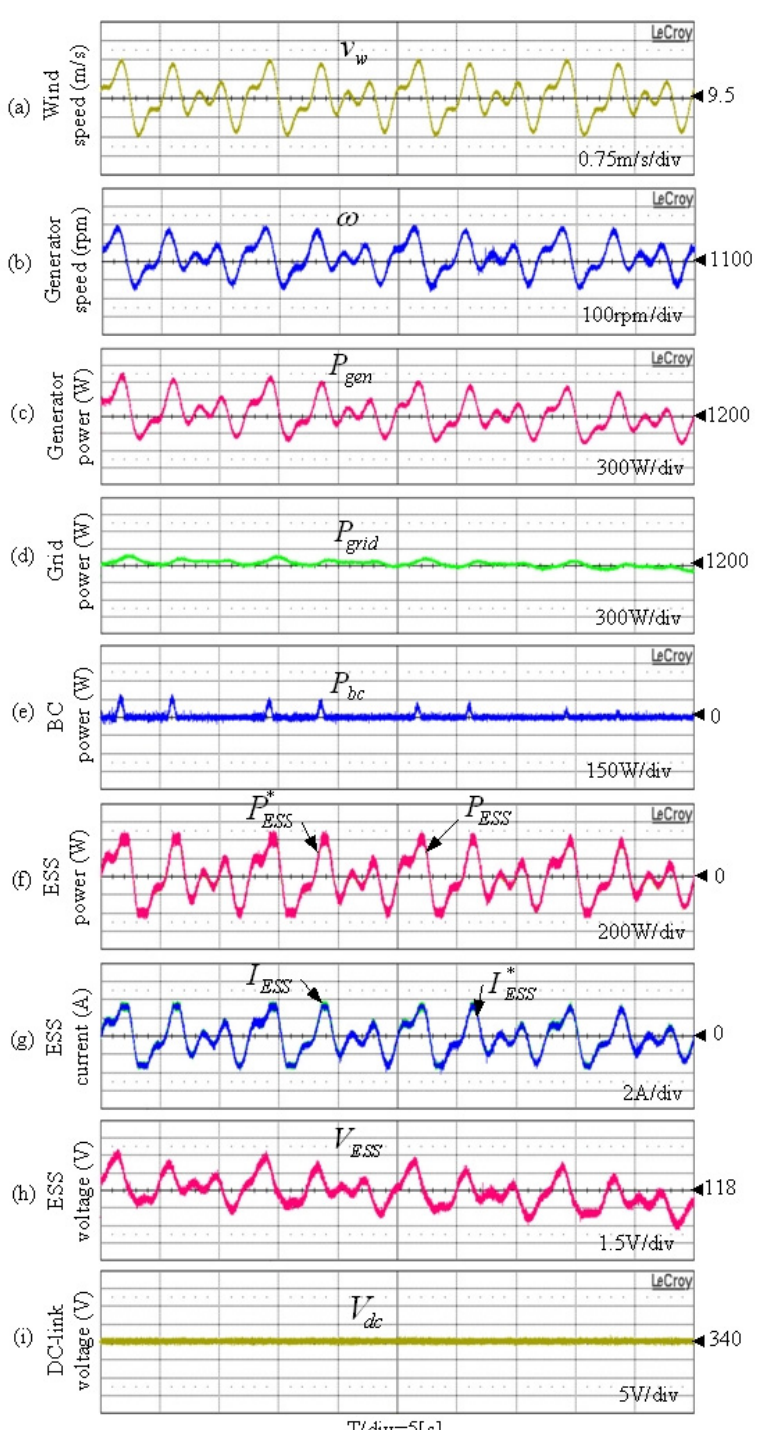
Figure 12. Power fluctuation mitigation for varying wind velocity. ( a ) Wind velocity. ( b ) Generator speed. ( c ) PMSG power. ( d ) Power flows into the grid. ( e ) Power of BRs. ( f ) Power of supercapacitor. ( g ) Supercapacitor current. ( h ) Voltage of supercapacitor. ( i ) DC-link voltage.